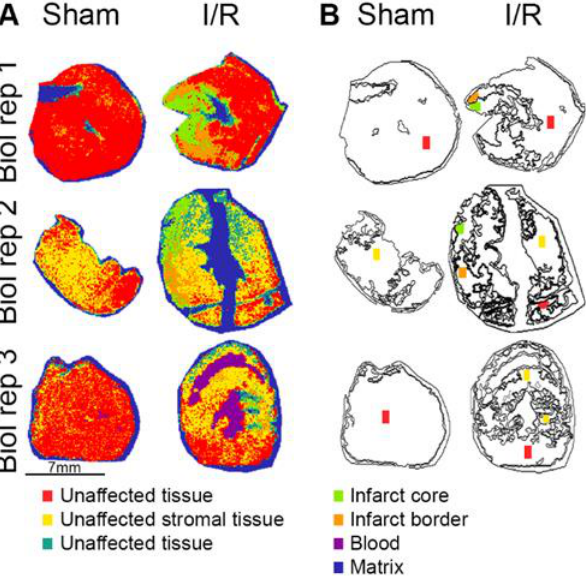
Figure 3. Segmentation analysis of sham and I/R hearts divided the tissue over seven clusters, separating infarct, unaffected tissue, blood and matrix. ( A ) The segmentation results showed a representation of the infarct core by the green and infarct border by orange clusters, while the red, yellow and turquoise clusters corresponded to unaffected tissue. Blood and matrix were represented by the purple and blue clusters, respectively. ( B ) Based on the segmentation results different ROIs were selected for proteomic analysis. The colored regions (approximately 0.5 mm 2 ) were ablated using LMD. Biol rep = biological replicate.